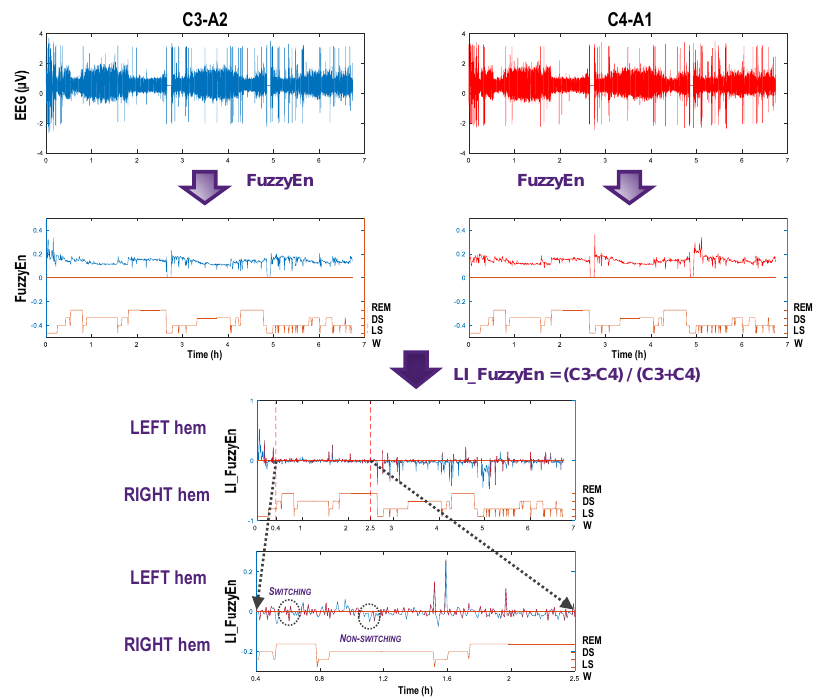
Figure 2. Block diagram of the method. EEG signals from both C3-A2 and C4-A1 channels are acquired, and the fuzzy entropy is calculated to indicate the unilateral brain activity. To reflect the activity difference or asymmetry between both hemispheres, the laterality index is calculated from the fuzzy entropy features. Then the LI distribution and brain switching could be clearly shown along with the sleep states.